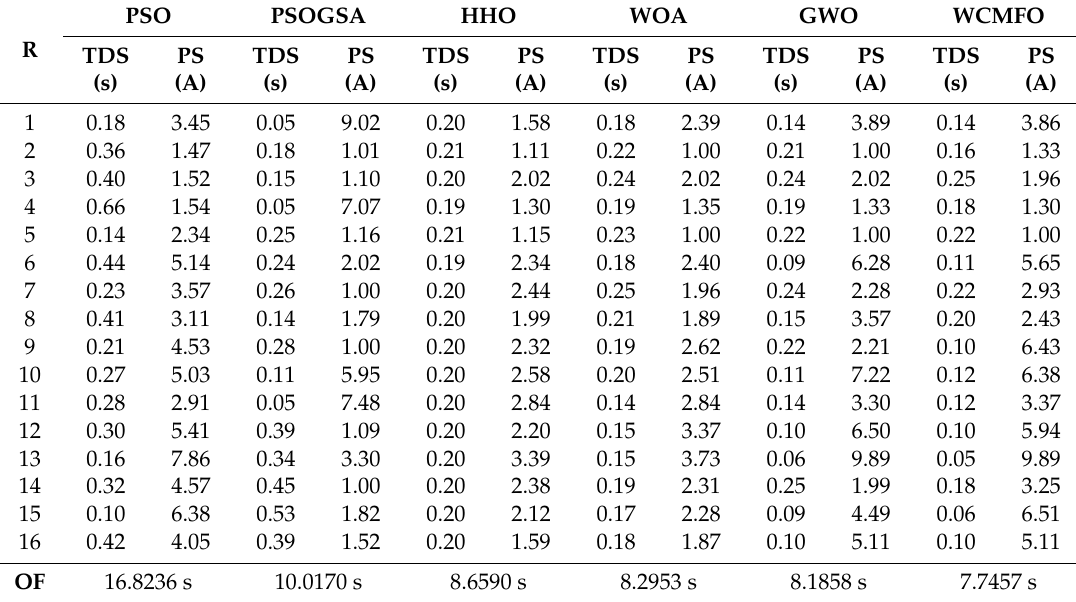
Table 13. Time dial setting (TDS) and pick-up setting (PS) by di ff erent algorithms compared against objective function value.